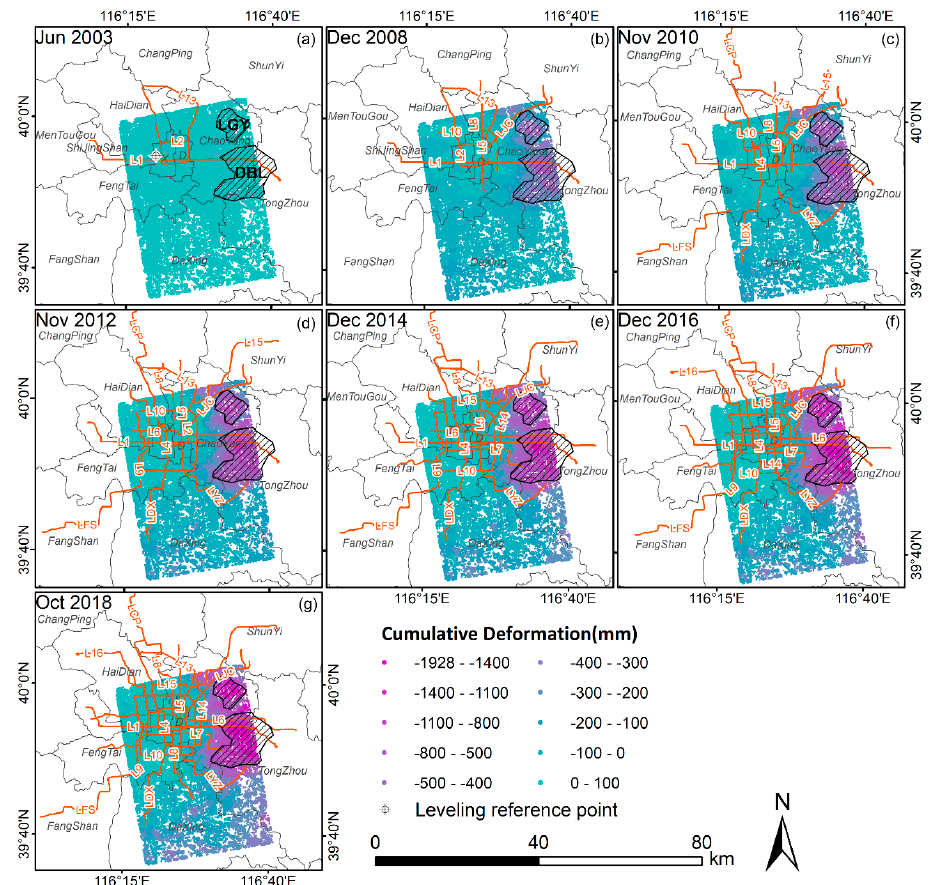
Figure 4. Mapping of MMTI-TSF analysis results superimposed on time-series development of Beijing Subway, from June 2003 to October 2018. The solid orange lines represent the subway lines of Beijing in existence in the corresponding years. The coordinates of the leveling reference point are: 116.334E, 39.916E.